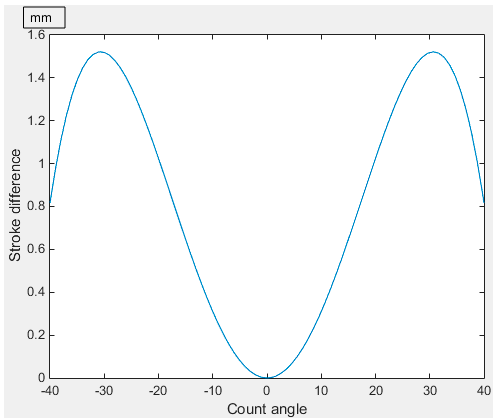
Figure 13. Curve of the stroke difference of a cylinder with steering angle.